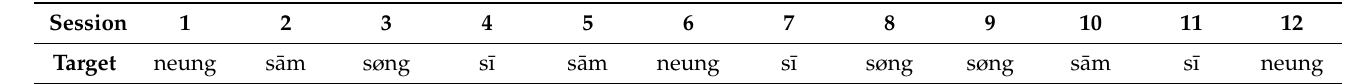
Table 4. Target of the auditory ERP components using stimuli as numeral sounds with a duration of 100 and 250